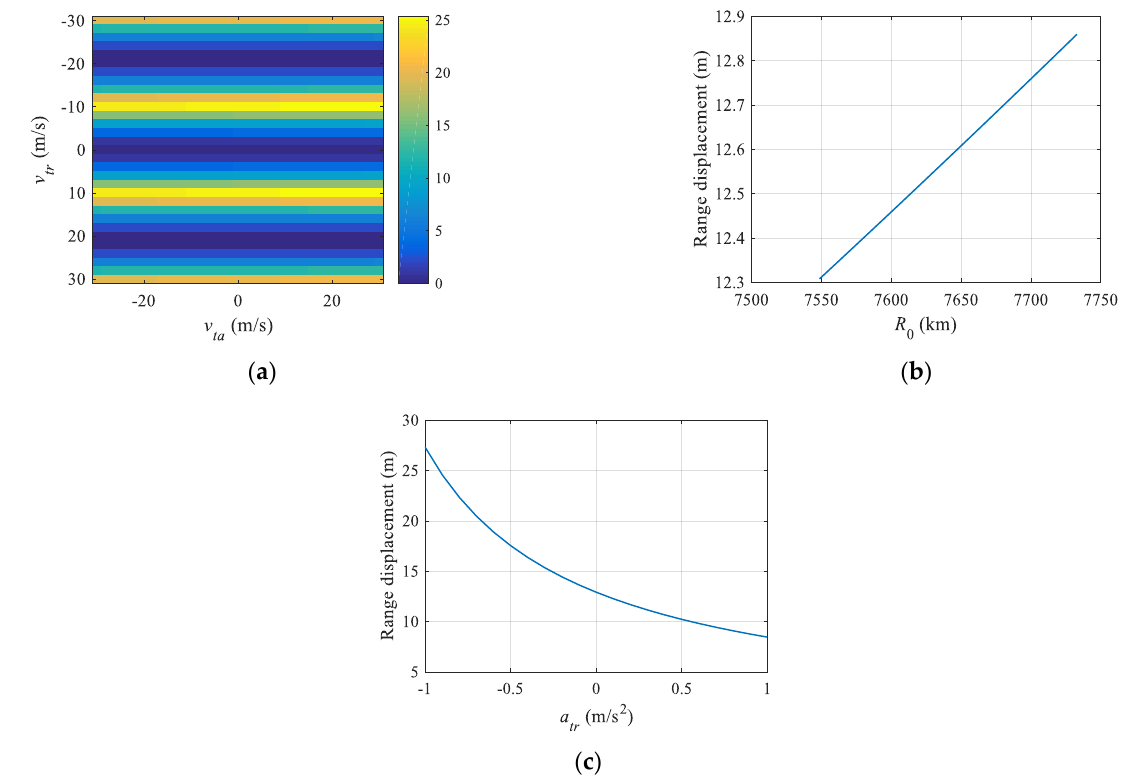
Figure 4. Dependences of the range displacement on the parameters of the target. (a) r shift versus v tr and v ta , where a tr = 0.1 m/s 2 , a ta = 0.2 m/s 2 , R 0 = 7568.7 km ; ( b ) r shift versus R 0 , the a tr = 0.1 m/s 2 , a ta = 0.2 m/s 2 , v tr = 7 m/s, v ta = 15 m/s; ( c ) r shift versus a tr , where a ta = 0.2 m/s 2 , v tr = 7 m/s, v ta = 15 m/s, R 0 = 7568.7 km.